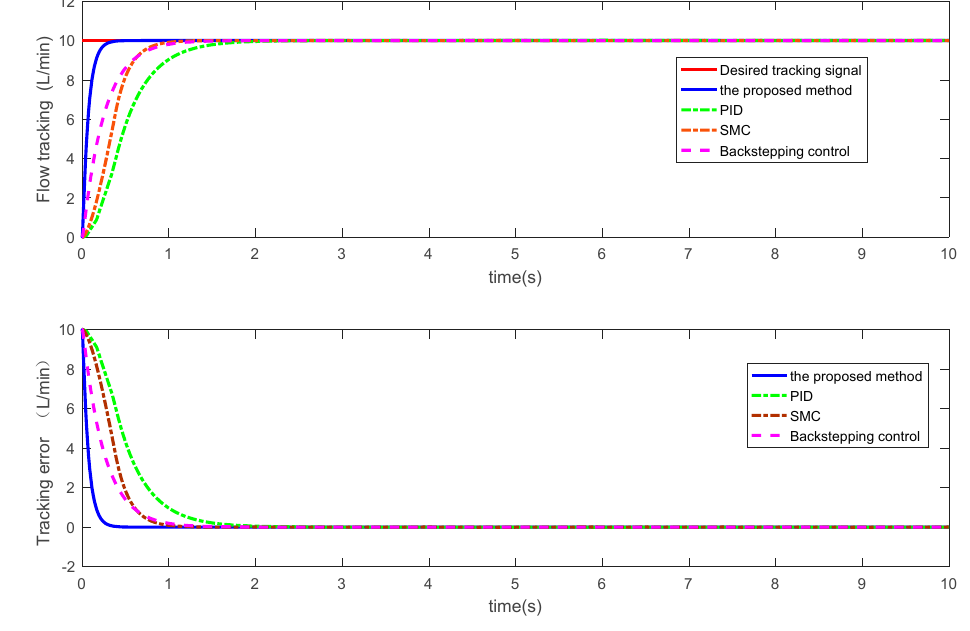
Figure 5. Time response of glue flow tracking and tracking error.